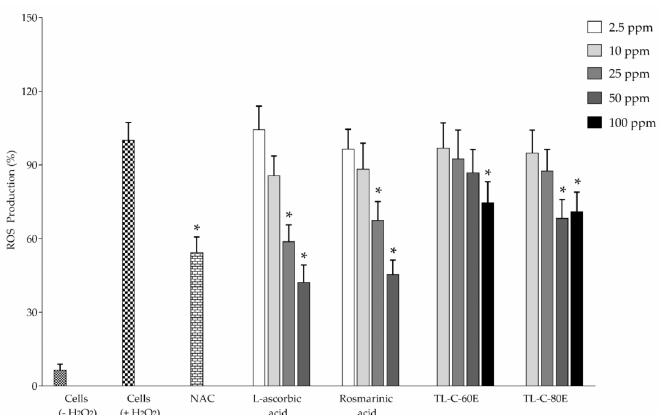
Figure 2. Effects of SRAEE on H 2 O 2 -induced ROS in NHDF cells. N-acetylcysteine (NAC, 80 µ M), L-ascorbic acid (250 mM), and rosmarinic acid (150 mM) were used as positive controls. Data represents the mean ± SD of three independent experiments. * Indicate a significant difference of experimental samples versus treated cells with H 2 O 2 induction ( p < 0.05).